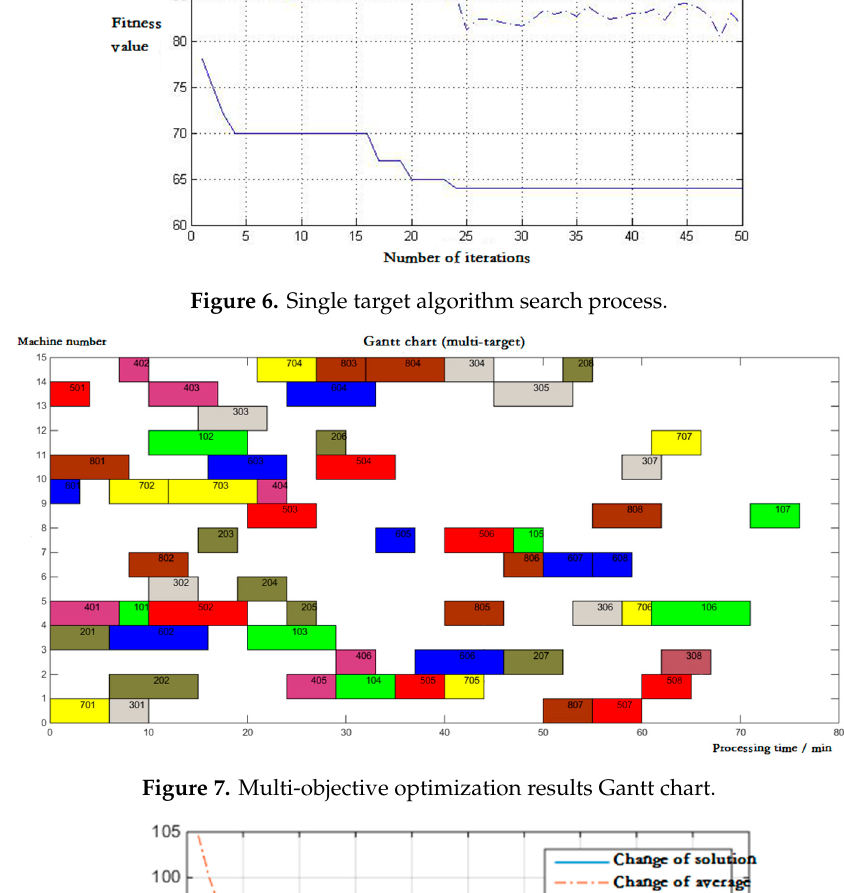
Figure 6. Single target algorithm search process.